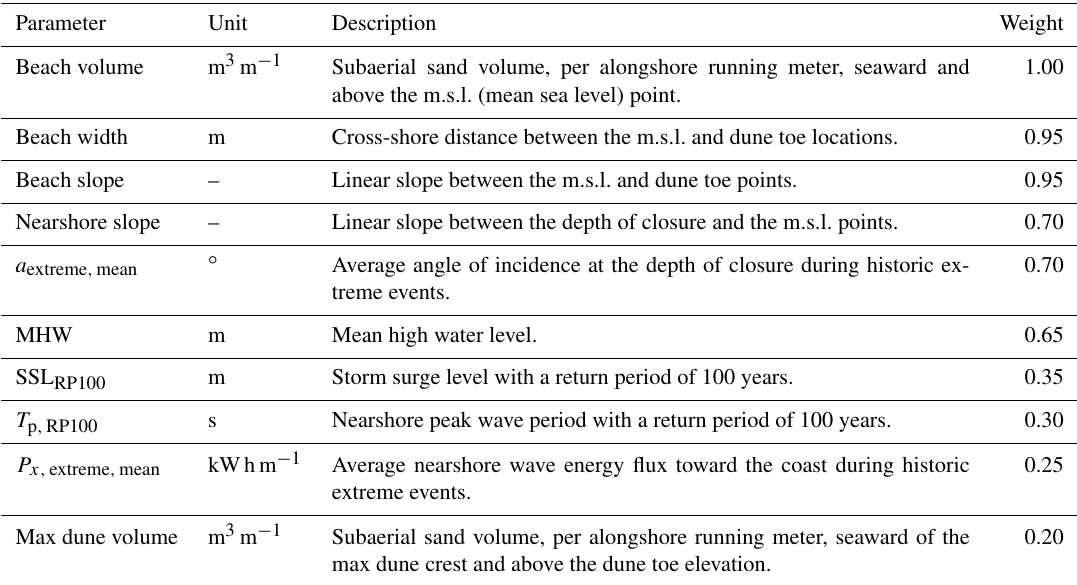
Table 1. Morphological and hydrodynamic parameters used to characterize each profile in the clustering procedure along with their individual weights. A brief description of each parameter is provided. For more detailed information please see Athanasiou et al.